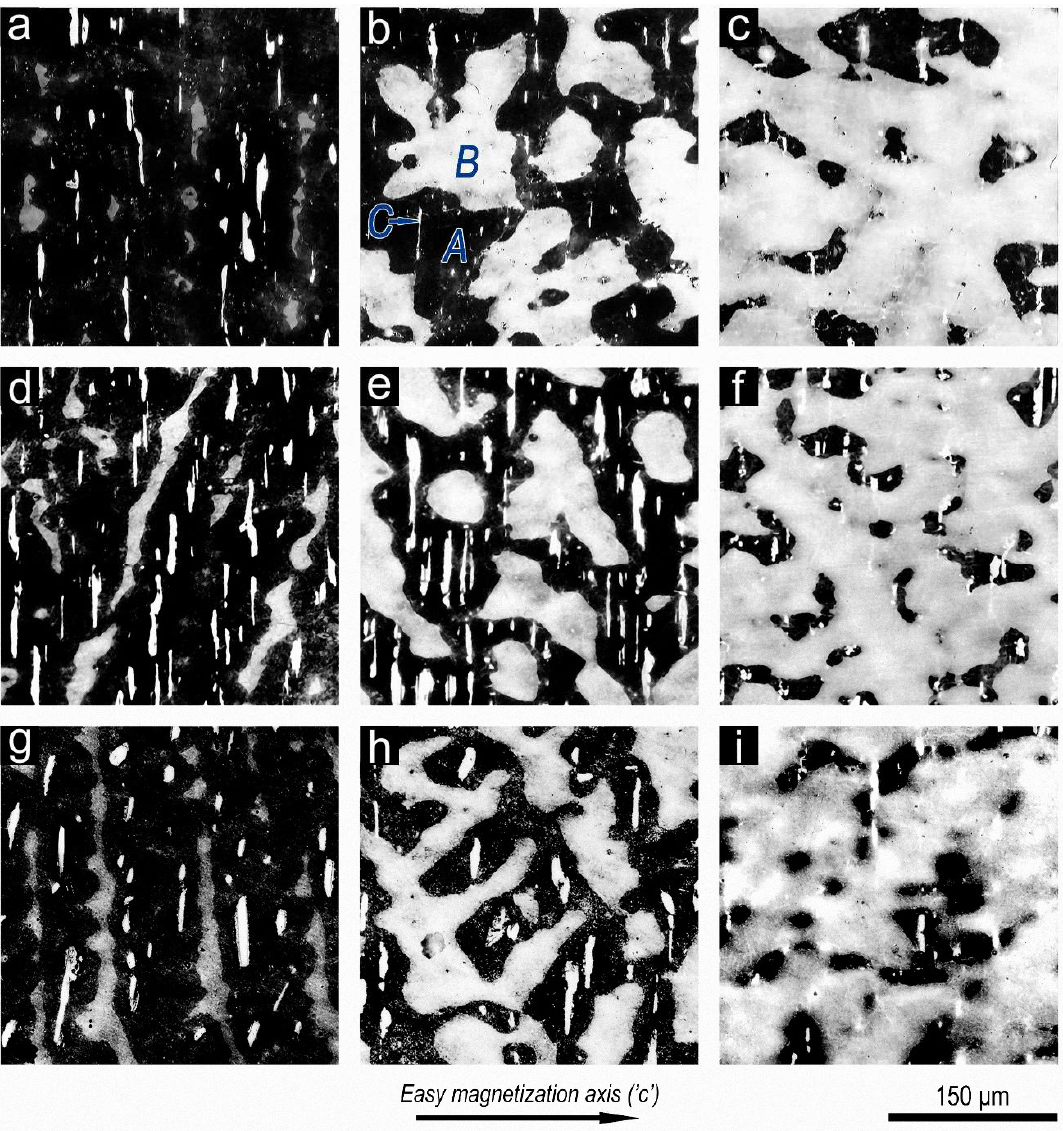
Figure 1. Typical microstructures of pseudo-single-crystal samples (etched) in the high-coercivity state: ( a – c )— Sm 0.85 Zr 0.15 (Co 0.702 Cu 0.088 Fe 0.210 ) z (with z = ( a ) 6.0, ( b ) 6.5, and ( c ) 6.8); ( d – f )—Sm 0.81 Zr 0.19 (Co 0.702 Cu 0.088 Fe 0.210 ) z (with z = ( d ) 6.0, ( e ) 6.3, and ( f ) 6.7), and ( g – i )—Sm 0.85 Zr 0.15 (Co 0.665 Cu 0.075 Fe 0.260 ) z (with z = ( g ) 6.0, ( h ) 6.4, and ( i ) 6.7).